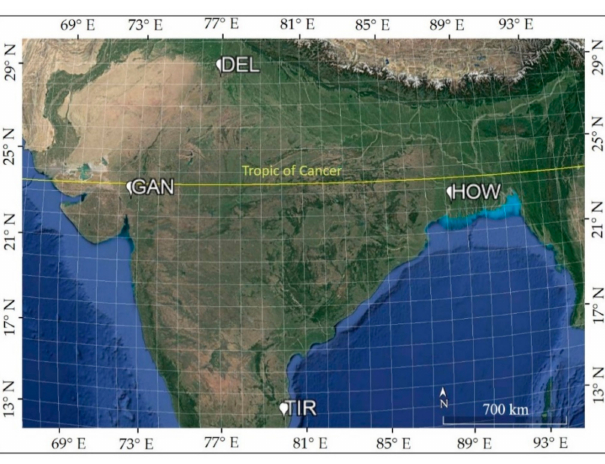
Figure 1. Study region and sun photometer